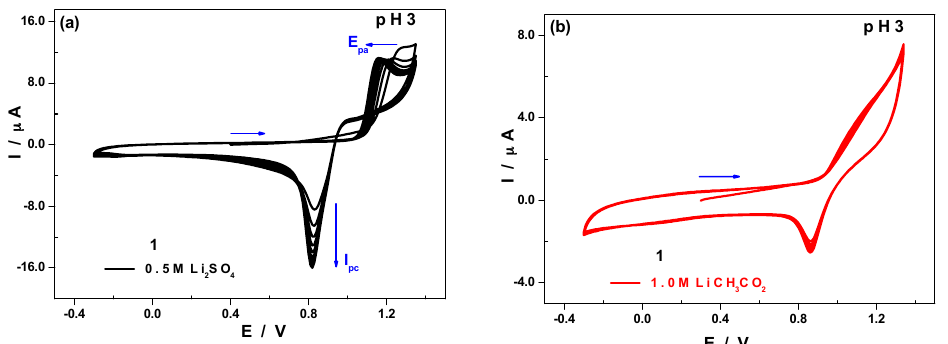
Figure 6. CVs of 1 at pH 3 in different media; polyoxometalate concentration: 0.5 mM; scan rate: 10 mV · s − 1 ; working electrode: glassy carbon; reference electrode: SCE. ( a ) 0.5 M Li 2 SO 4 + H 2 SO 4 : cycling (10 scans) between − 0.3 V and +1.35 V; ( b ) 1.0 M CH 3 COOLi + CH 3 COOH: cycling (10 scans) between − 0.3 V and +1.35